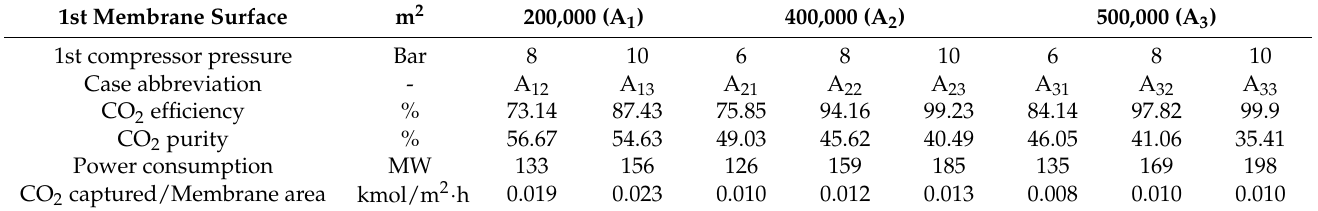
Table 9. The specific parameters were chosen for the technical and economical assessment of a single-stage of membrane technology (no vacuum pump used), case (A).